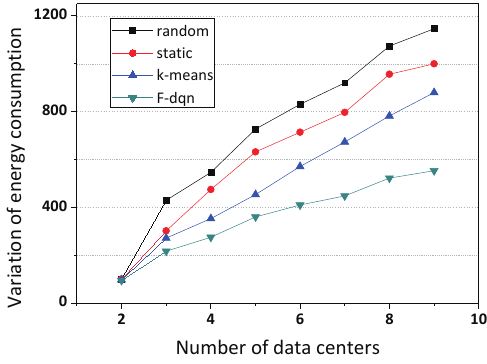
Figure 7. The Comparison of Variation of Energy